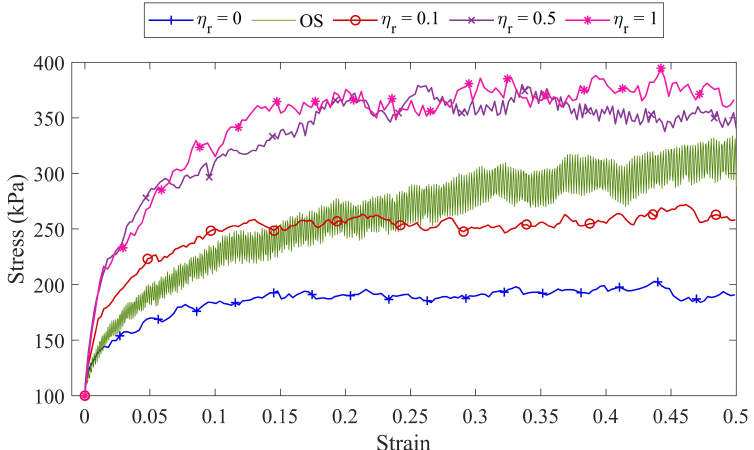
Figure 4. A comparison between the shear behavior of the overlapped spheres particle model (OS) and the rolling resistance model with different coefficients of rolling friction ( η r ).